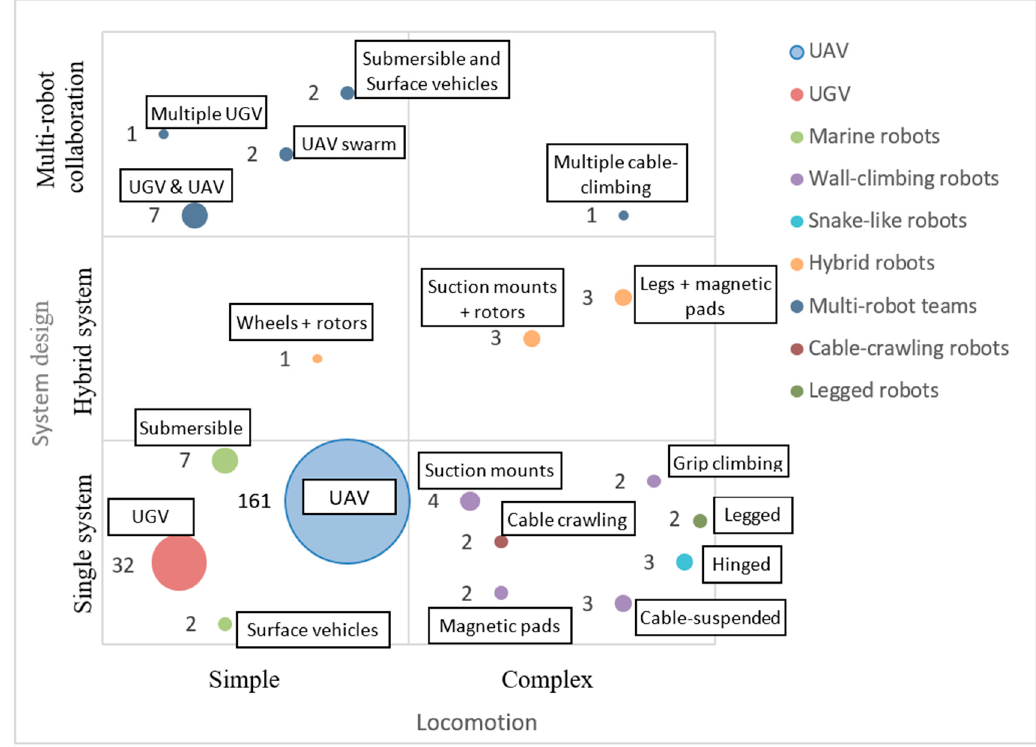
Figure 3. Types of robots used in literature.